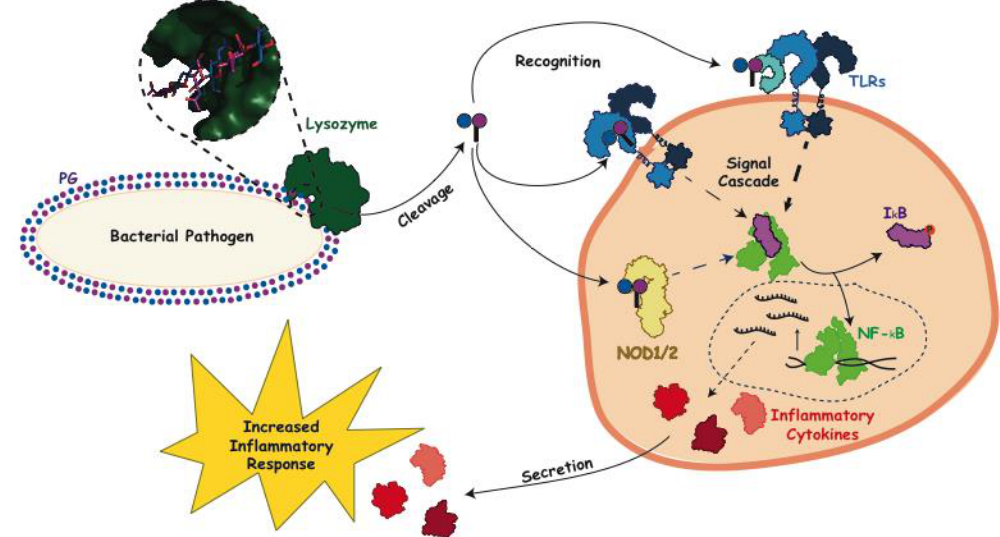
Figure 3 . General immune inflammatory response following the lytic action of lysozyme. Upon bacterial invasion lysozyme (PDB ID: 5NJQ, dark green) acts to cleave the PG sacculus and release monomers consisting of GlcNAc-MurNAc (peptide). These monomers then act as a signaling molecule binding to extracellular pattern recognition receptors on the surface of immune cells, e.g., toll-like receptor 2 (TLR2) (PDB ID: 1FYW, 3A7C, blue), and initiate a response which is aided by